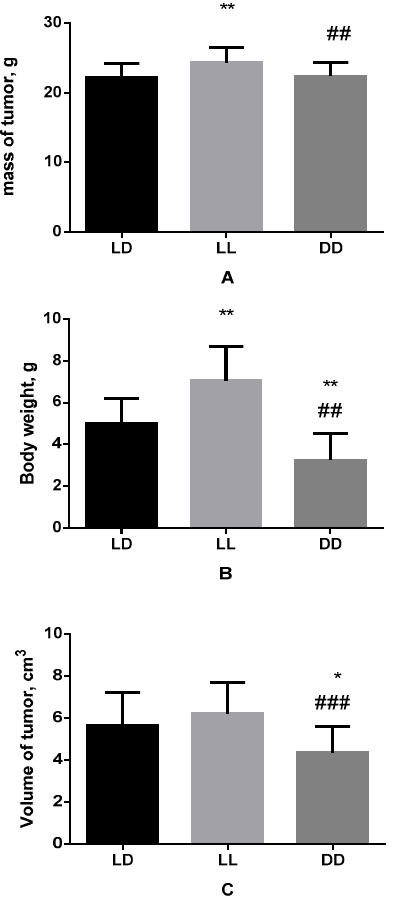
Figure 1. Influence of various light regimes on body weight of mice ( A ), mass of tumor ( B ) and its volume ( C ). Hereinafter: * ( p ≤ 0.05); ** ( p ≤ 0.005)—differences in comparison with the parameters of control group mice; ## ( p ≤ 0.005); ### ( p ≤ 0.0005)—differences in comparison with mice of LL